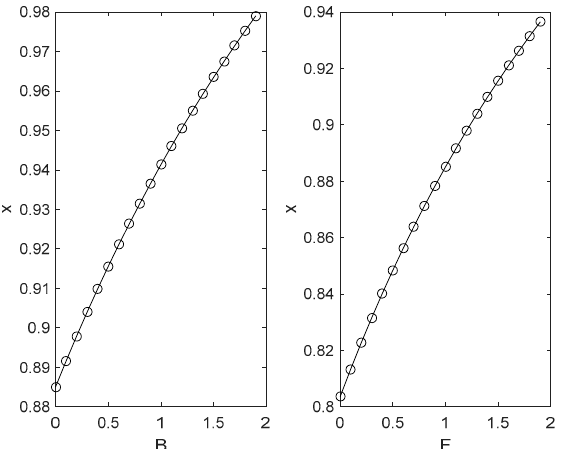
Figure 3. The impact of reward B and punishment F on enterprises’ green technology innov- ation behaviour.